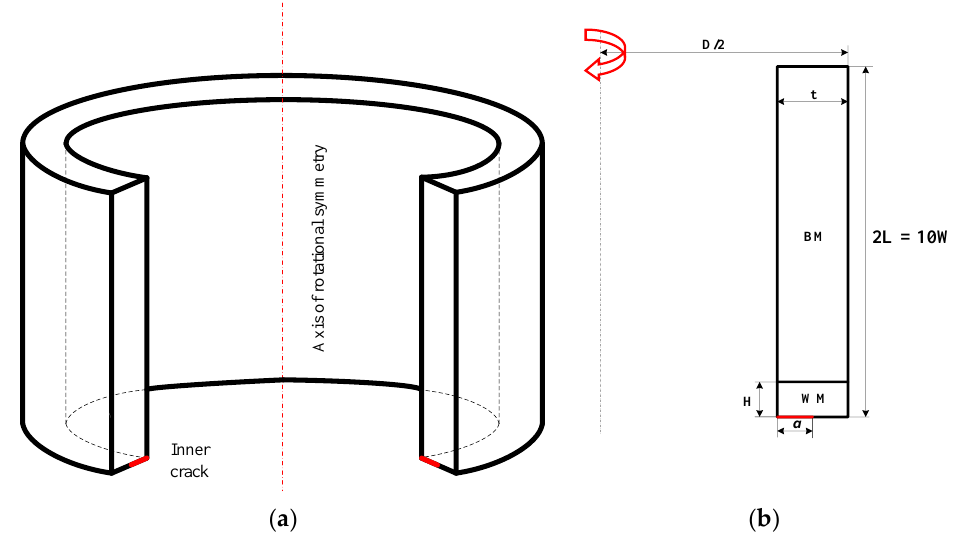
Figure 3. Schematic plots of pipe, ( a ) inner-cracked pipe; ( b ) schematic illustration of axisymmetric model.